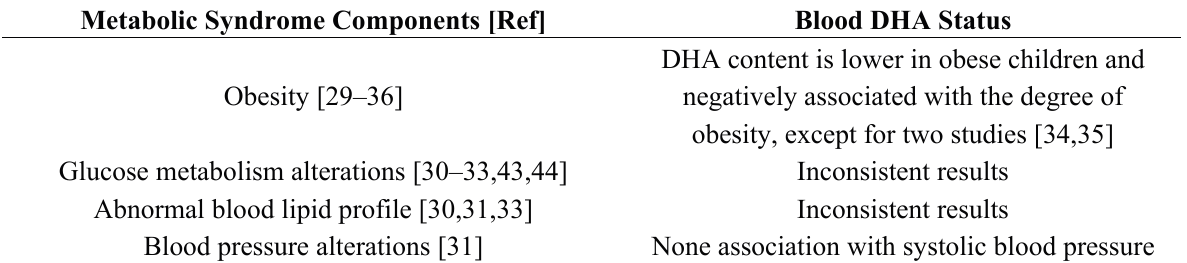
Table 1. DHA status in blood and components of IDF criteria for metabolic syndrome in obese